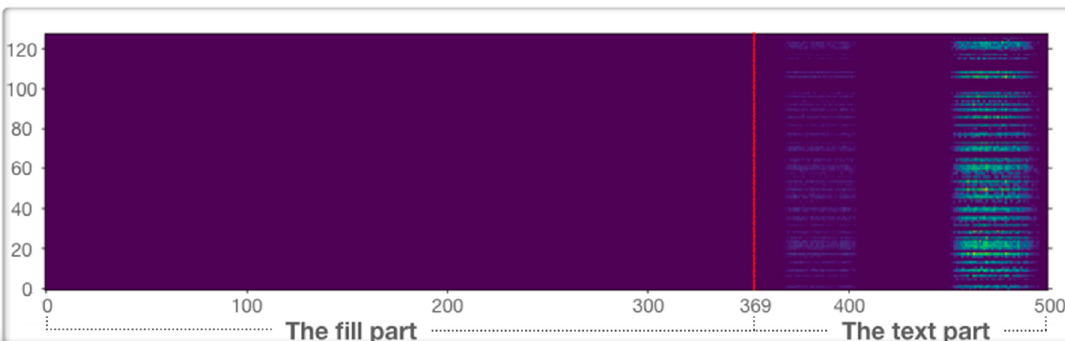
Figure 9. Visualization of the words embedding weight 14_8.